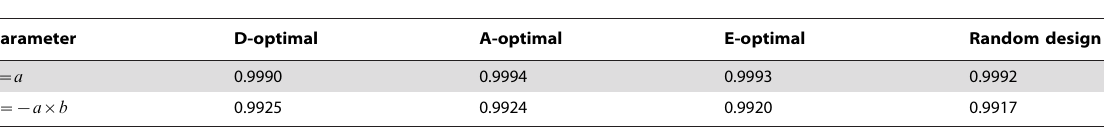
Table 1. Coverage frequency of